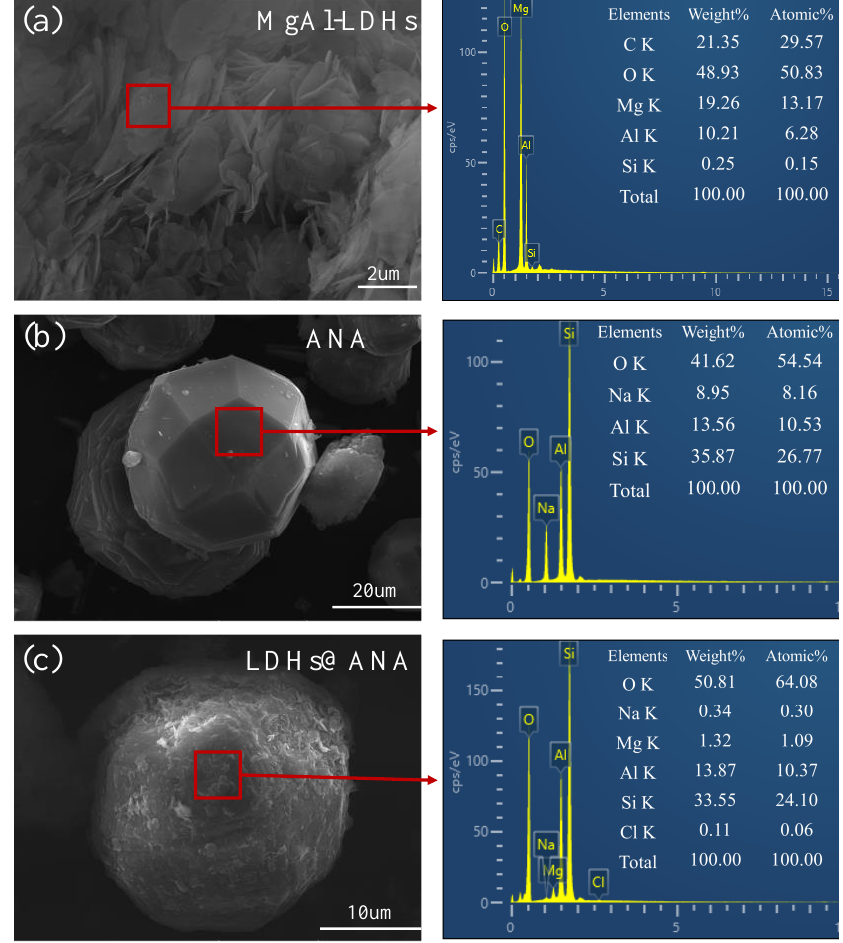
Figure 6. SEM images and EDS spectra of ( a ) MgAl-LDHs, ( b ) ANA, and ( c ) LDHs@ANA.